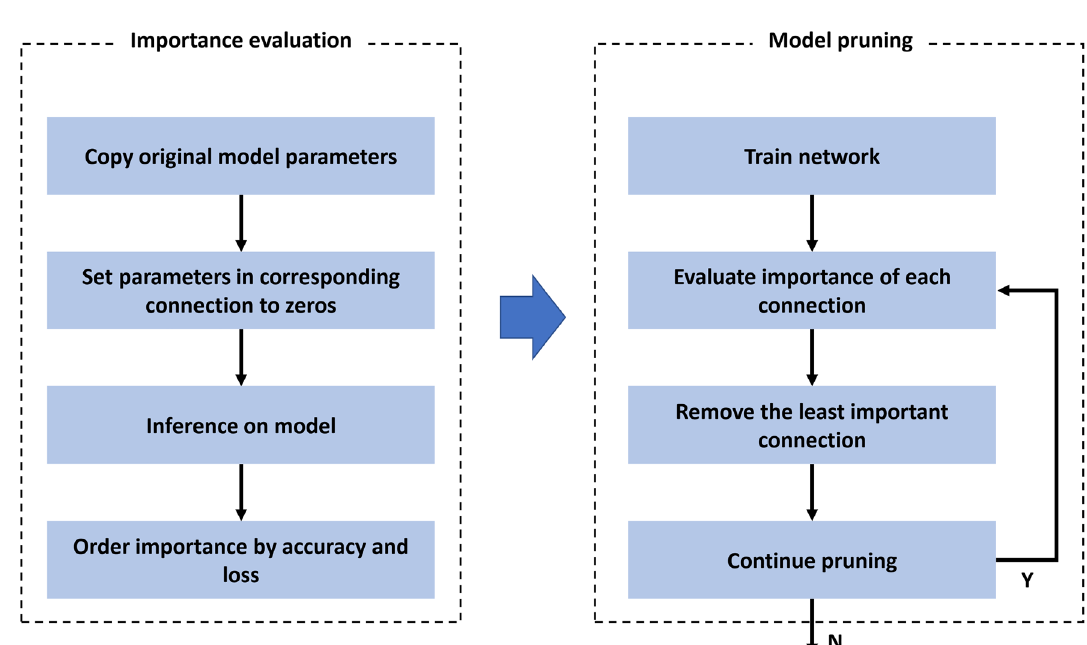
Figure 4. Overview of pruning process for cell-based